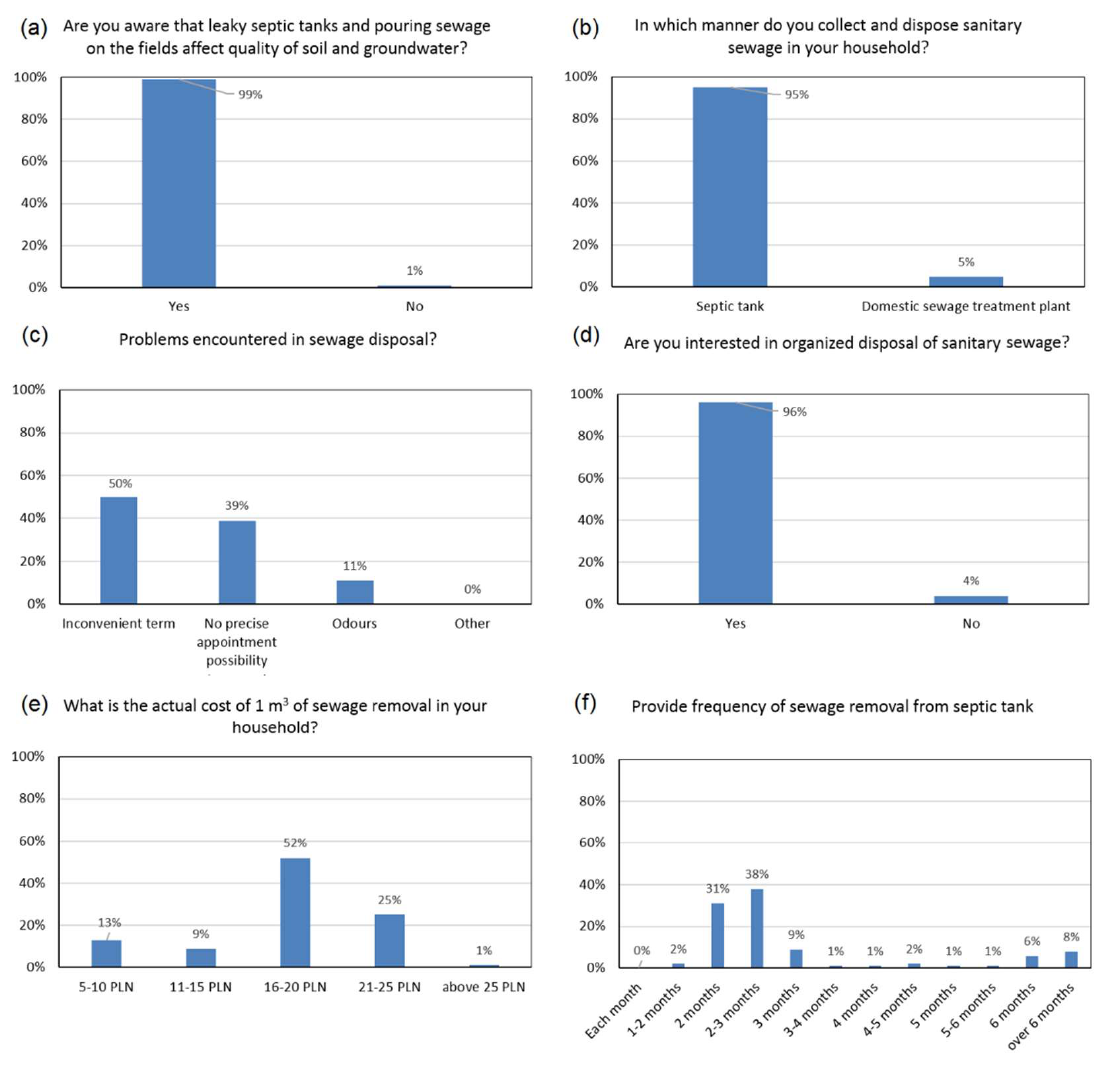
Figure 4. Results of willingness-to-accept questions.